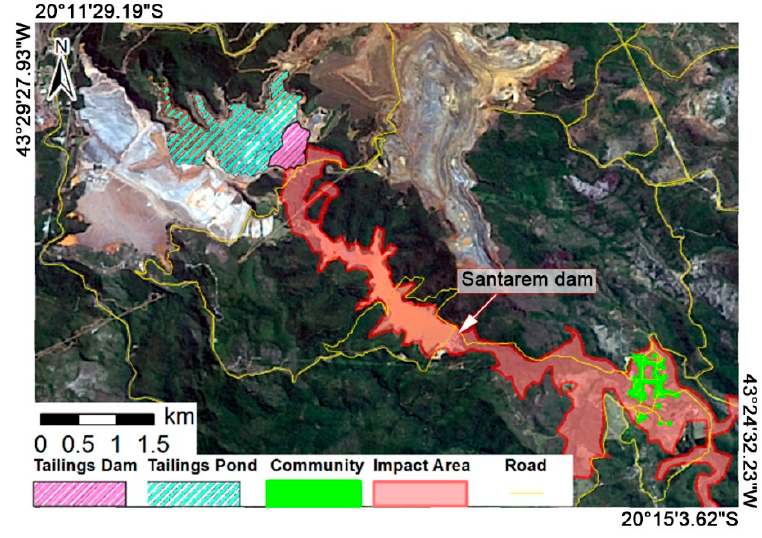
Figure 7. Locations of the Samarco collapsed tailings pond, submerged area and community.